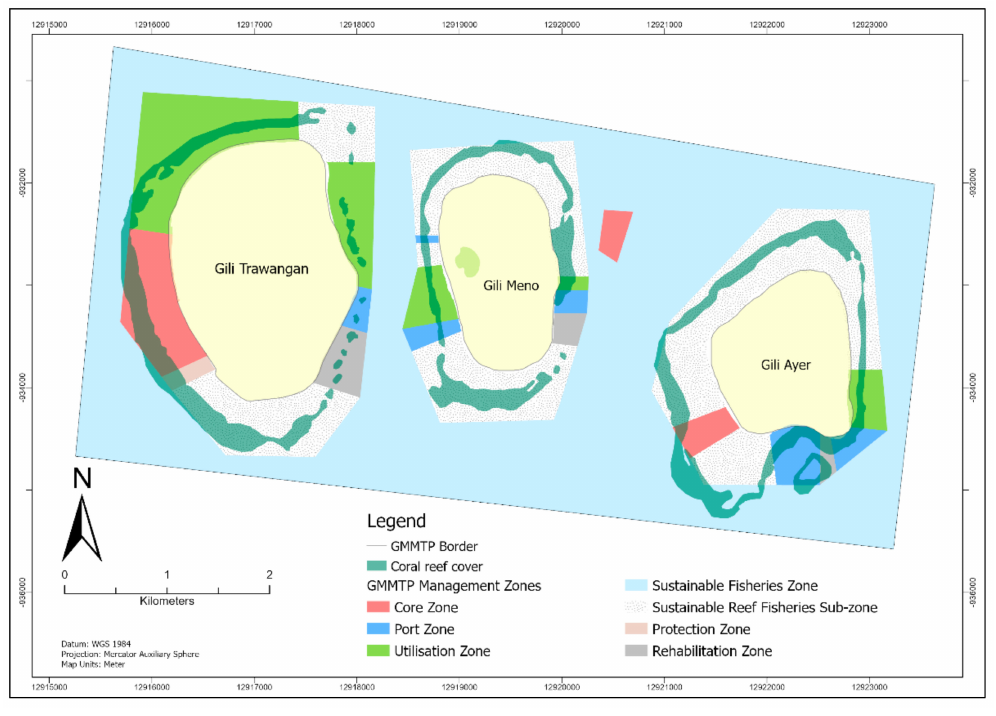
Figure 1. Map of Gili Matra Marine Tourism Park zoning system (Adapted and Modified from